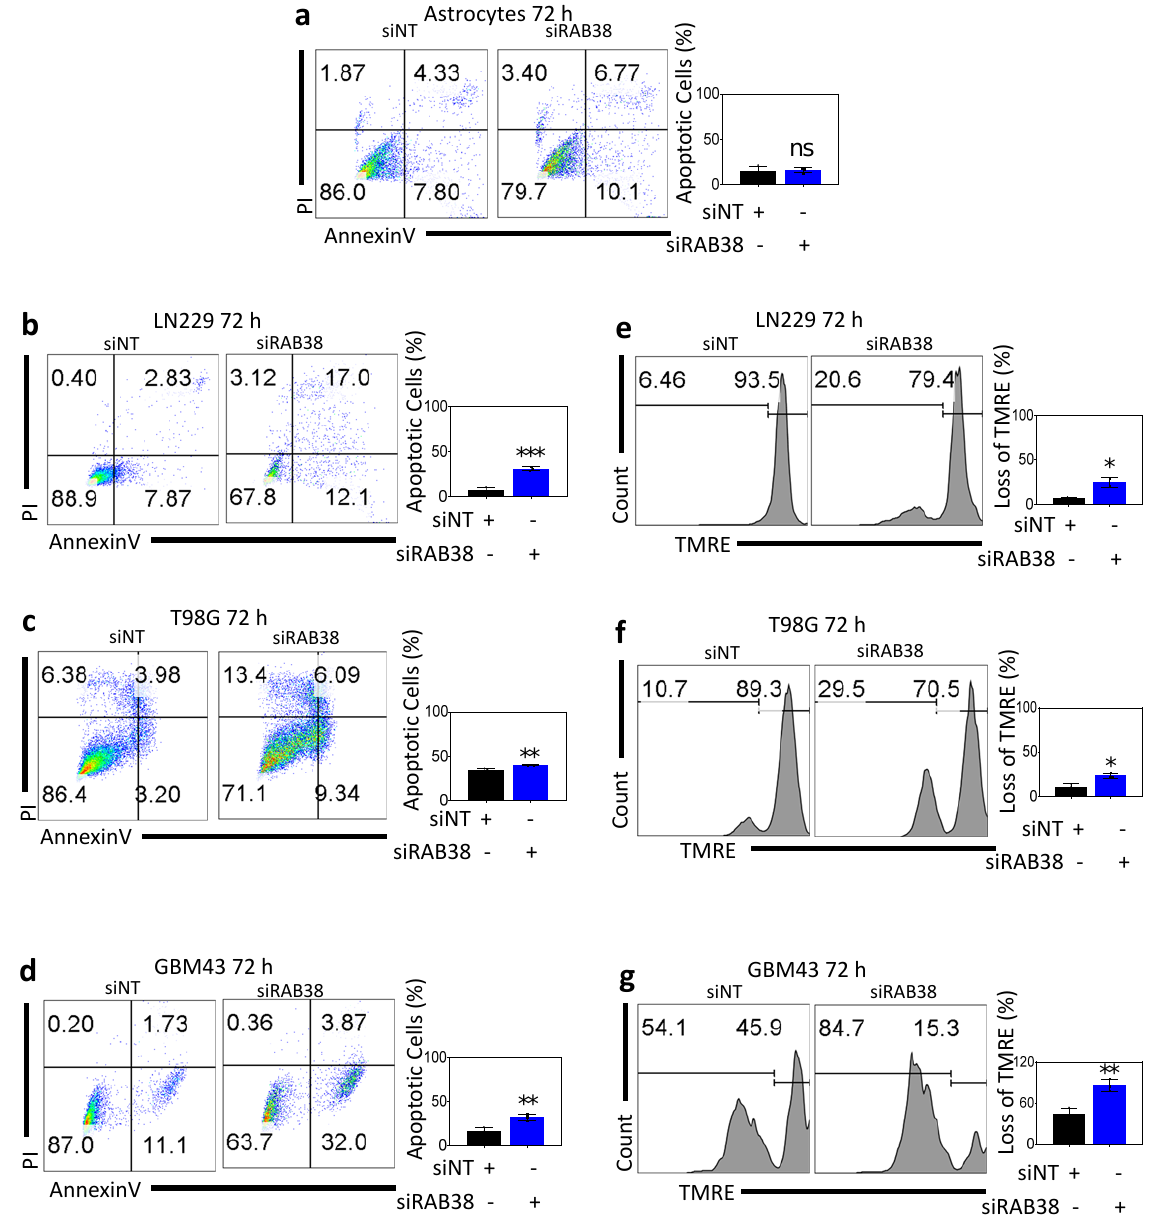
Figure 2. Loss of RAB38 function causes glioblastoma cell death associated with loss in mitochondrial membrane potential. ( a – d ) Astrocytes ( a ), LN229 ( b ), T98G ( c ), and GBM43 ( d ) glioblastoma cell lines were transfected with either NT or RAB38 siRNA and after 72 h were stained with annexin V/propidium iodide and analyzed by flow cytometry (representative plots shown). Representative plots and a histogram with statistical analysis are presented ( n = 3). ( e – g ) LN229 ( e ), T98G ( f ), and GBM43 ( g ) cells were transfected with either siNT or siRAB38 and after 72 h were stained with TMRE and analyzed by flow cytometry (representative plots shown). Representative plots and a histogram with statistical analysis are presented ( n = 3). * p < 0.05; ** p < 0.01; ***/**** p < 0.001, n.s. means not